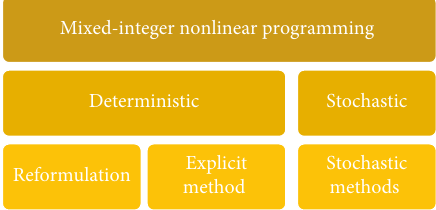
Figure 1: Mixed-integer nonlinear